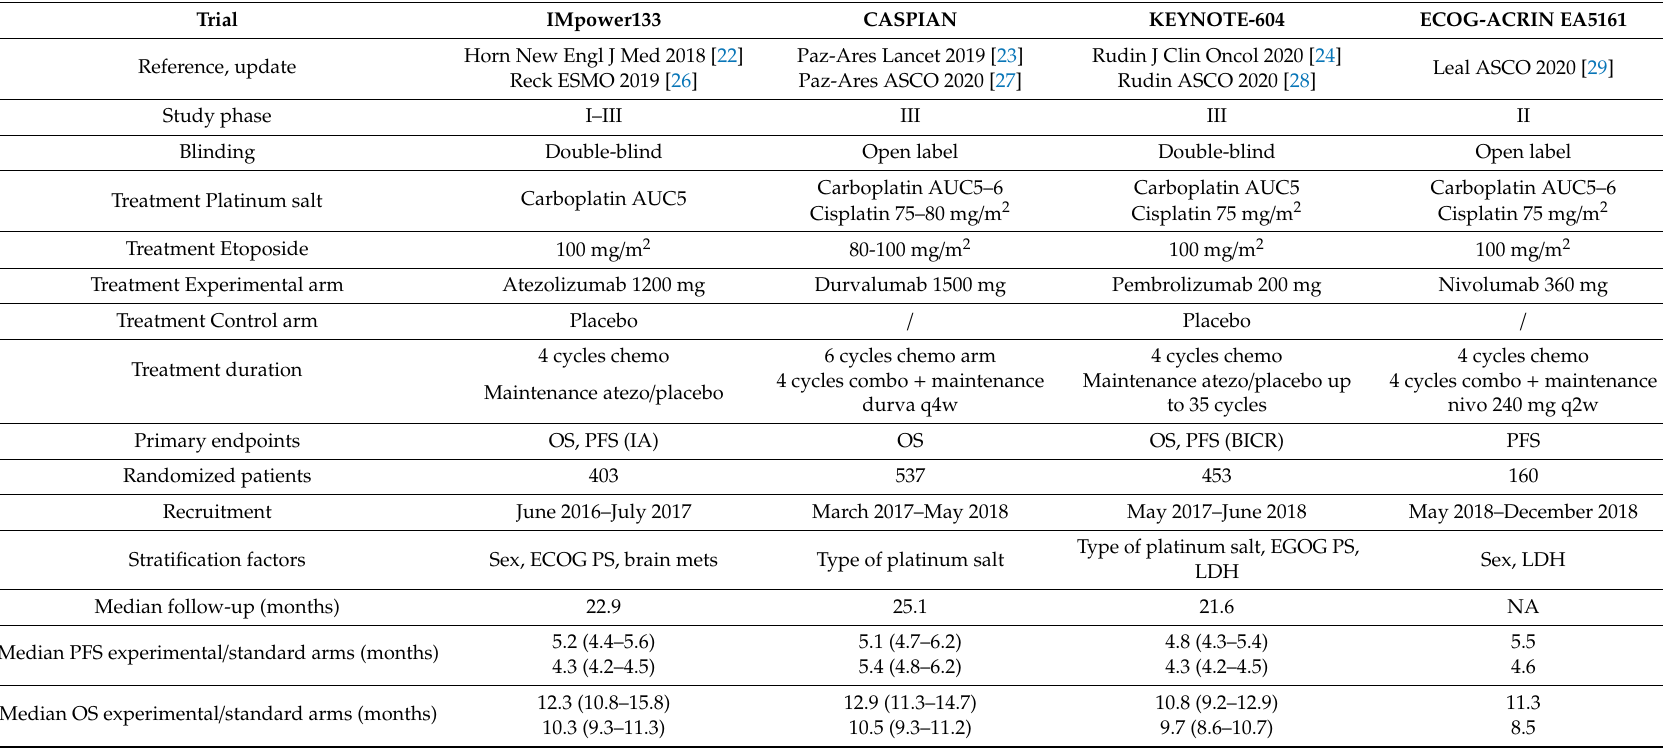
Table 1. Characteristics of the trials included in the